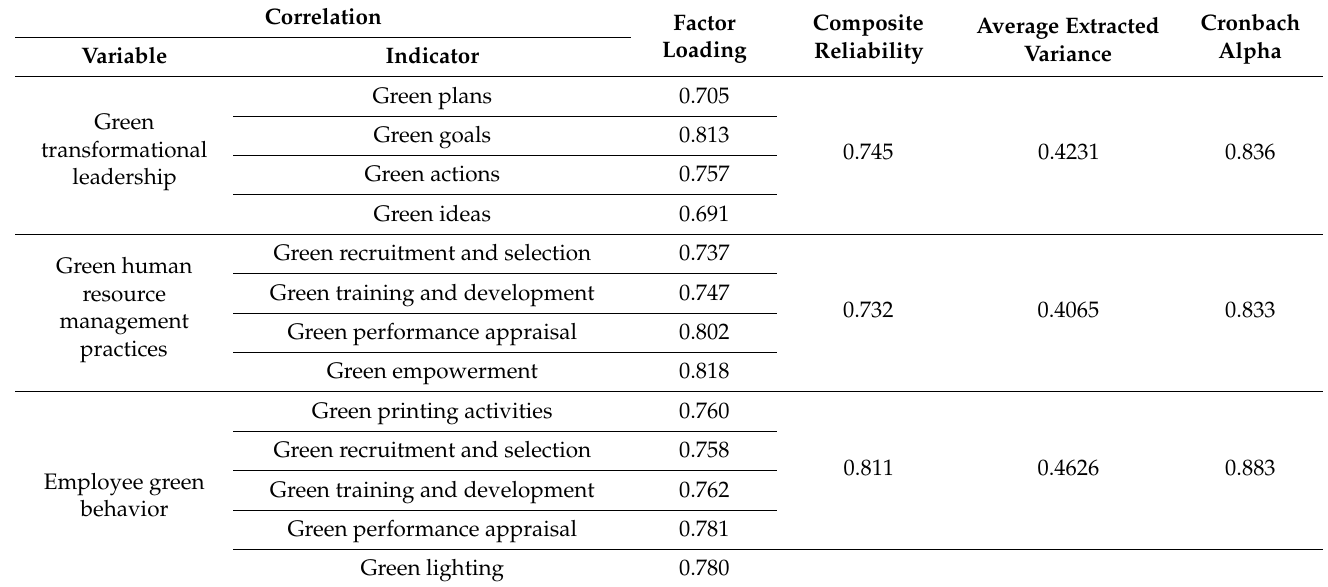
Table 3. Composite reliability, average extracted variance, and Cronbach